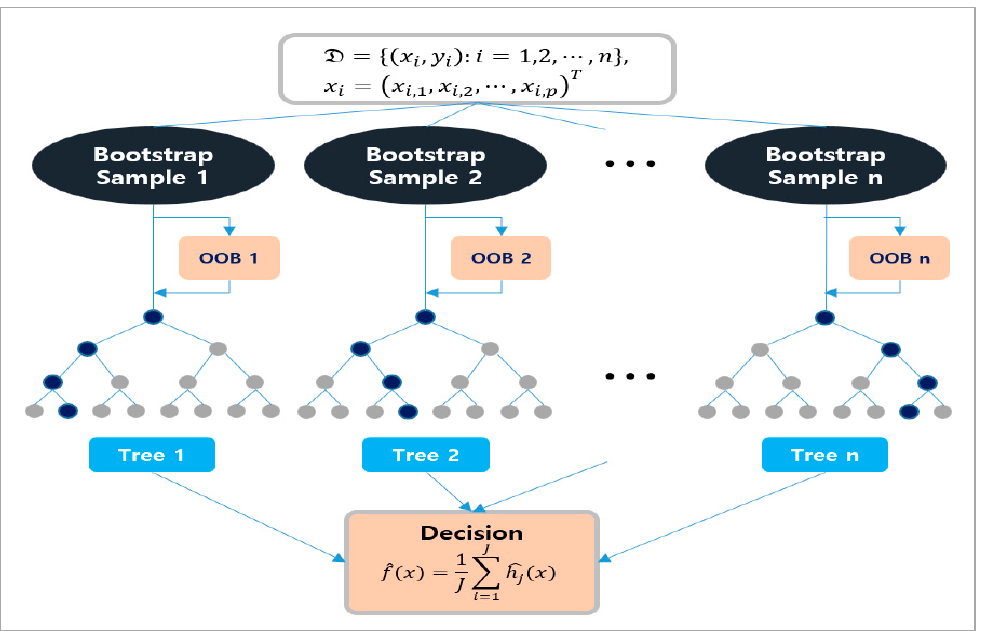
Figure 6. Random forest algorithm.